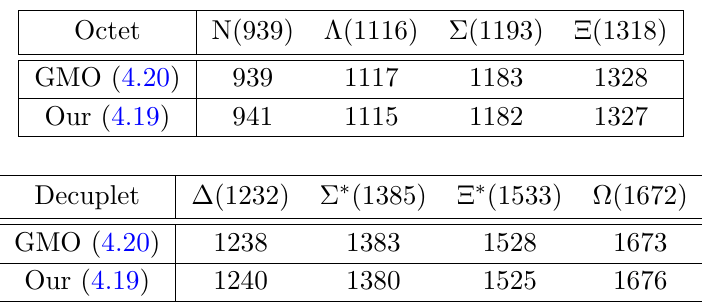
Table 2 . A numerical (cid:12)t of the hyperon spectrum by the original GMO mass formula (4.20) and our improved GMO mass formula